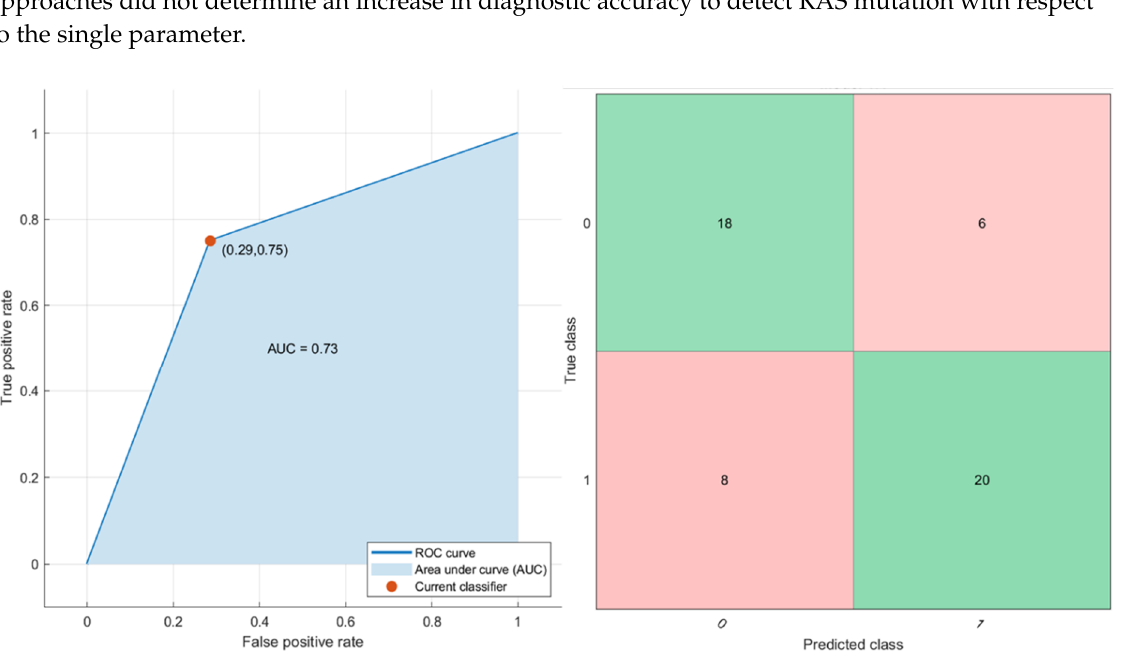
Figure 4. ROC curve and confusion matrix of the KNN tested considering all diffusion- and perfusion-extracted parameters by DWI and DKI.